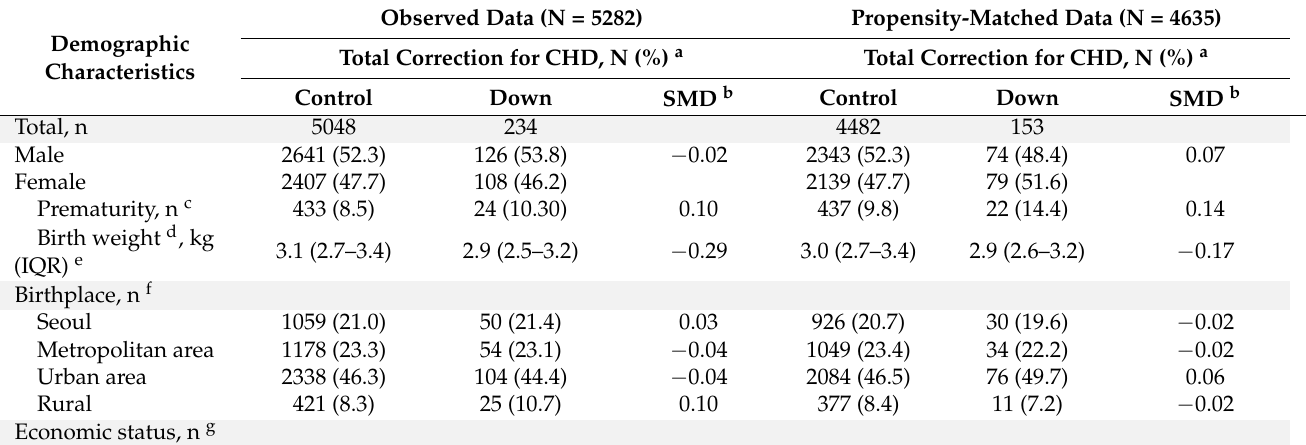
Table 1. Baseline demographic characteristics of the participants with and without Down syndrome who underwent total correction for congenital heart